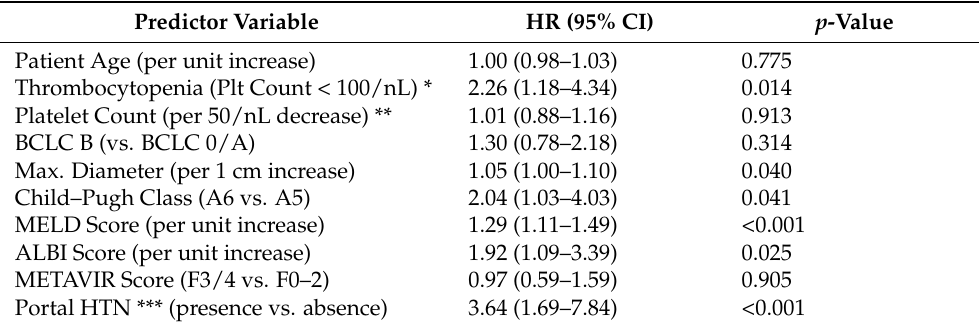
Table 3. Analysis of overall survival by simple Cox regression. Predictor